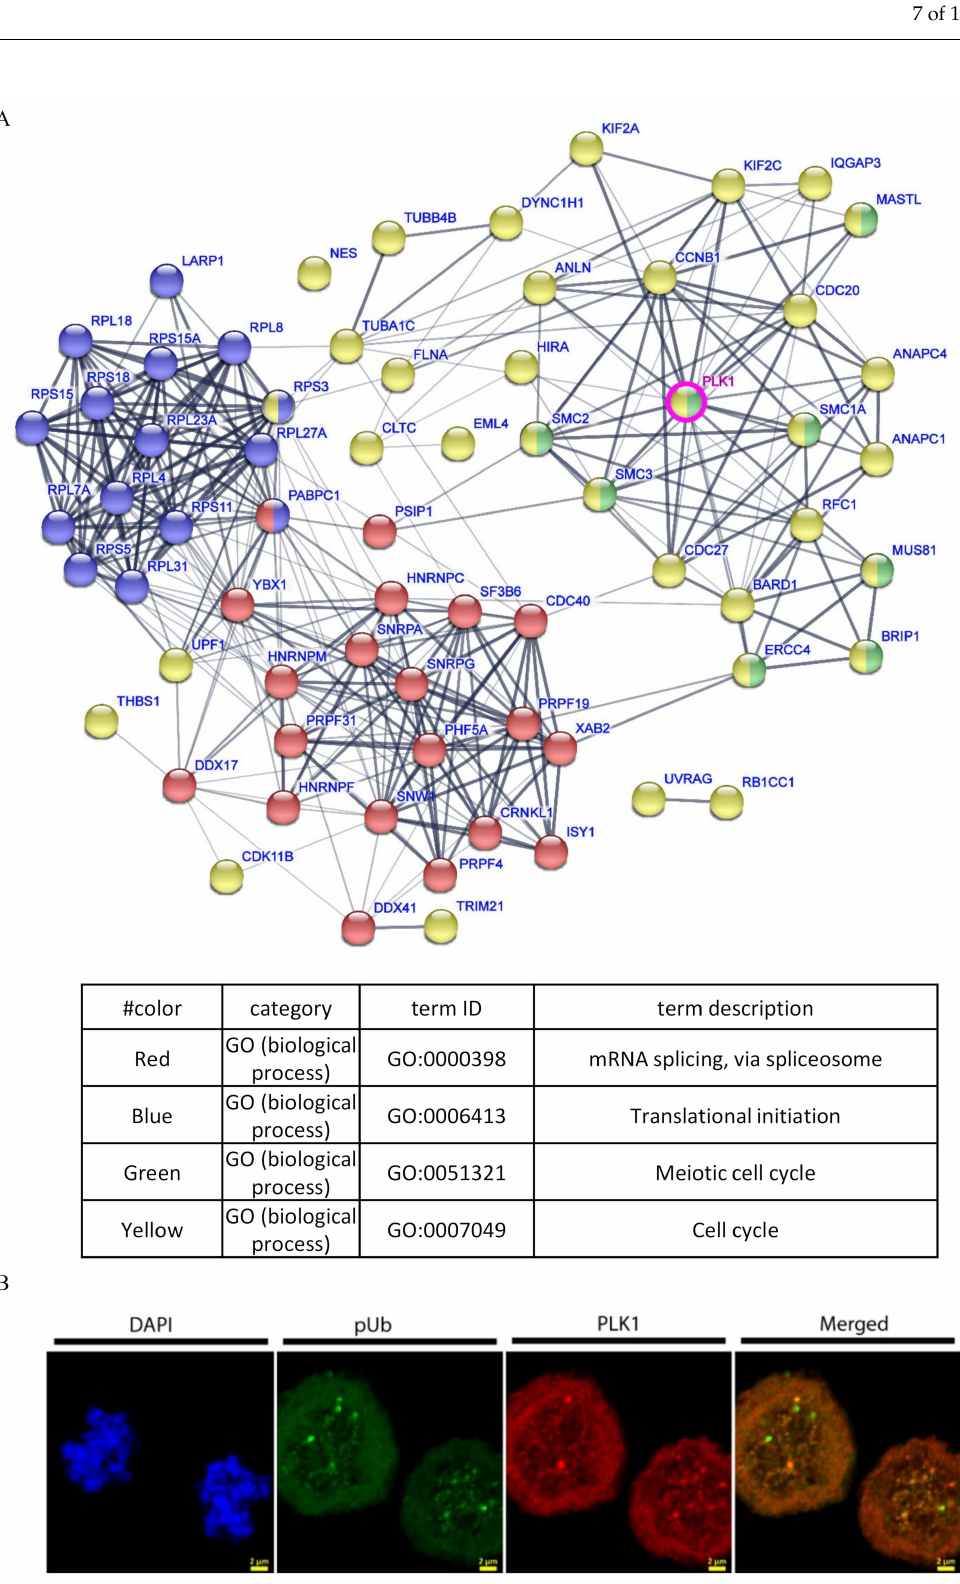
Figure 3. Immunoprecipitation from mitotic cells using the pUb antibody enriches various cell cycle-related proteins and the master regulator PLK1. ( A ) STRING analysis of proteins pulled down using anti-pUb from mitotic cells (Isotype control is anti-HA antibody). Only proteins that were significantly enriched by this antibody in three independent experiments are shown. Cell cycle, mitosis and mRNA splicing are highlighted in red, blue and green, respectively. PLK1 is highlighted by pink circle; ( B ) confocal image of mitotic U2OS cells stained for pUb (green), PLK1 (red) and DAPI (blue) show similar distribution in centrosomes. Scale bars are 2